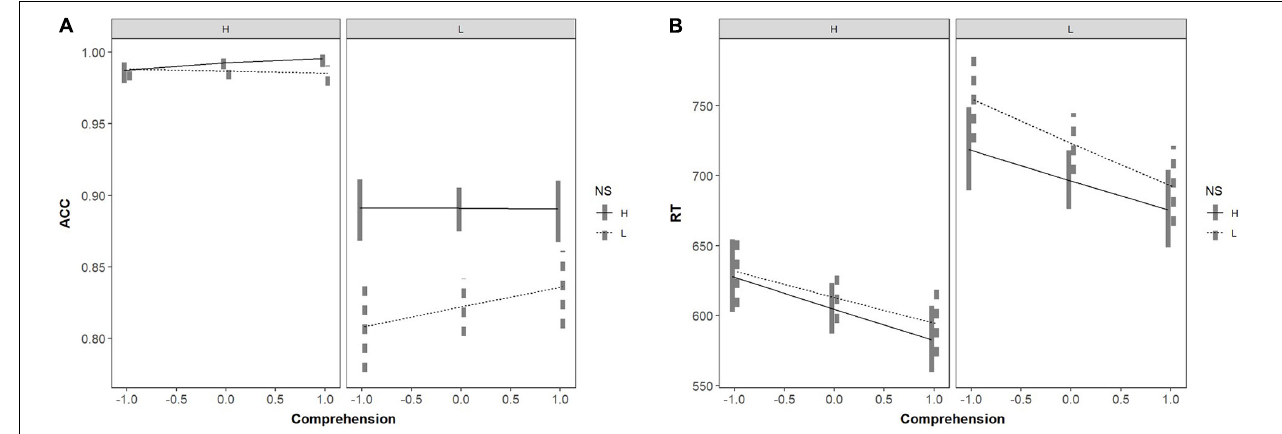
FIGURE 3 | Interaction among reading comprehension, WF, and NS in predicting (A) word recognition accuracy, and (B) word recognition reaction